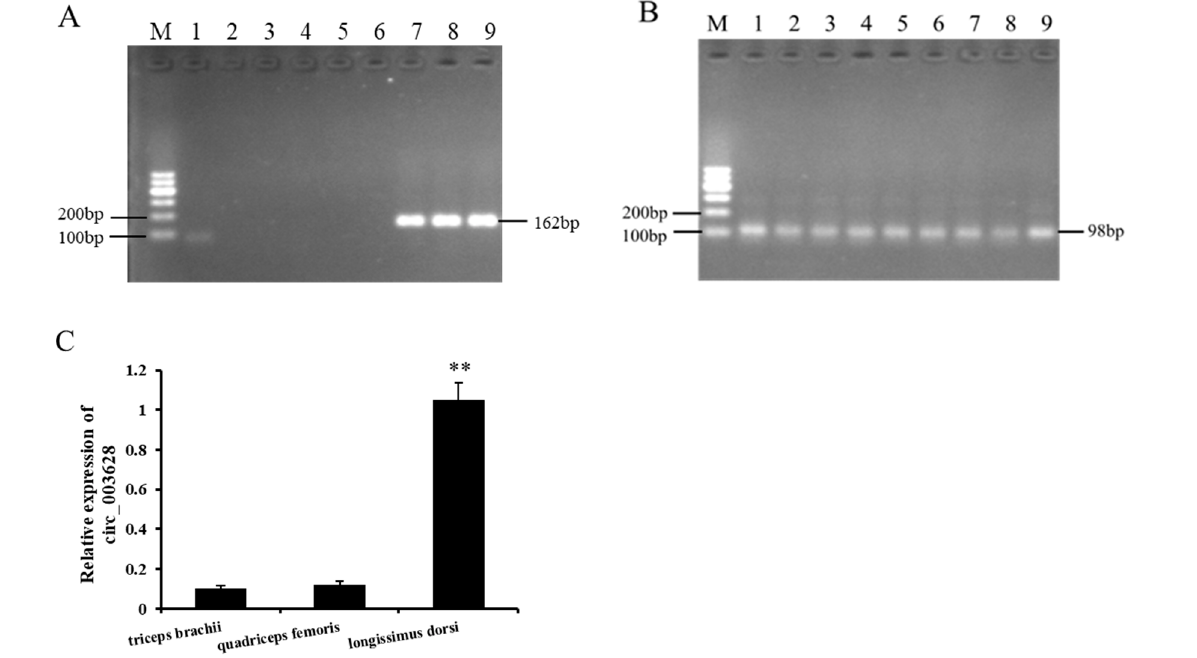
Figure 3. The expression of circ_003628 ( A ) and GAPDH ( B ) in different tissues collected from Ziwuling black goats. M: Marker; 1: heart; 2: liver; 3: spleen; 4: lung; 5: kidney; 6: testis; 7: triceps brachii muscle; 8: quadriceps femoris muscle; 9: longissimus dorsi muscle. ( C ) The relative expression level of circ_003628 in the three muscle tissues. ** p < 0.01.